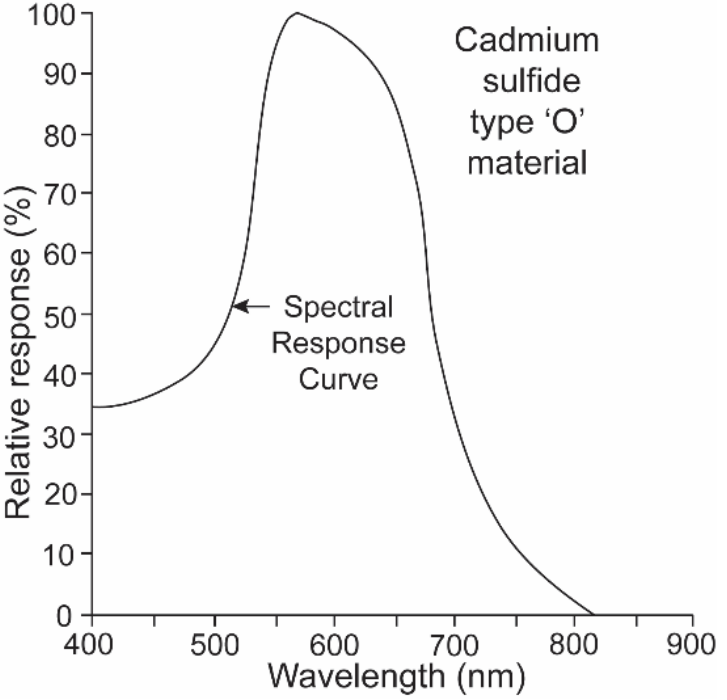
Figure 5. "O" type of cadmium sulfide with a broad spectral range was used to simulate the spec- tral sensitivity of the sharks.